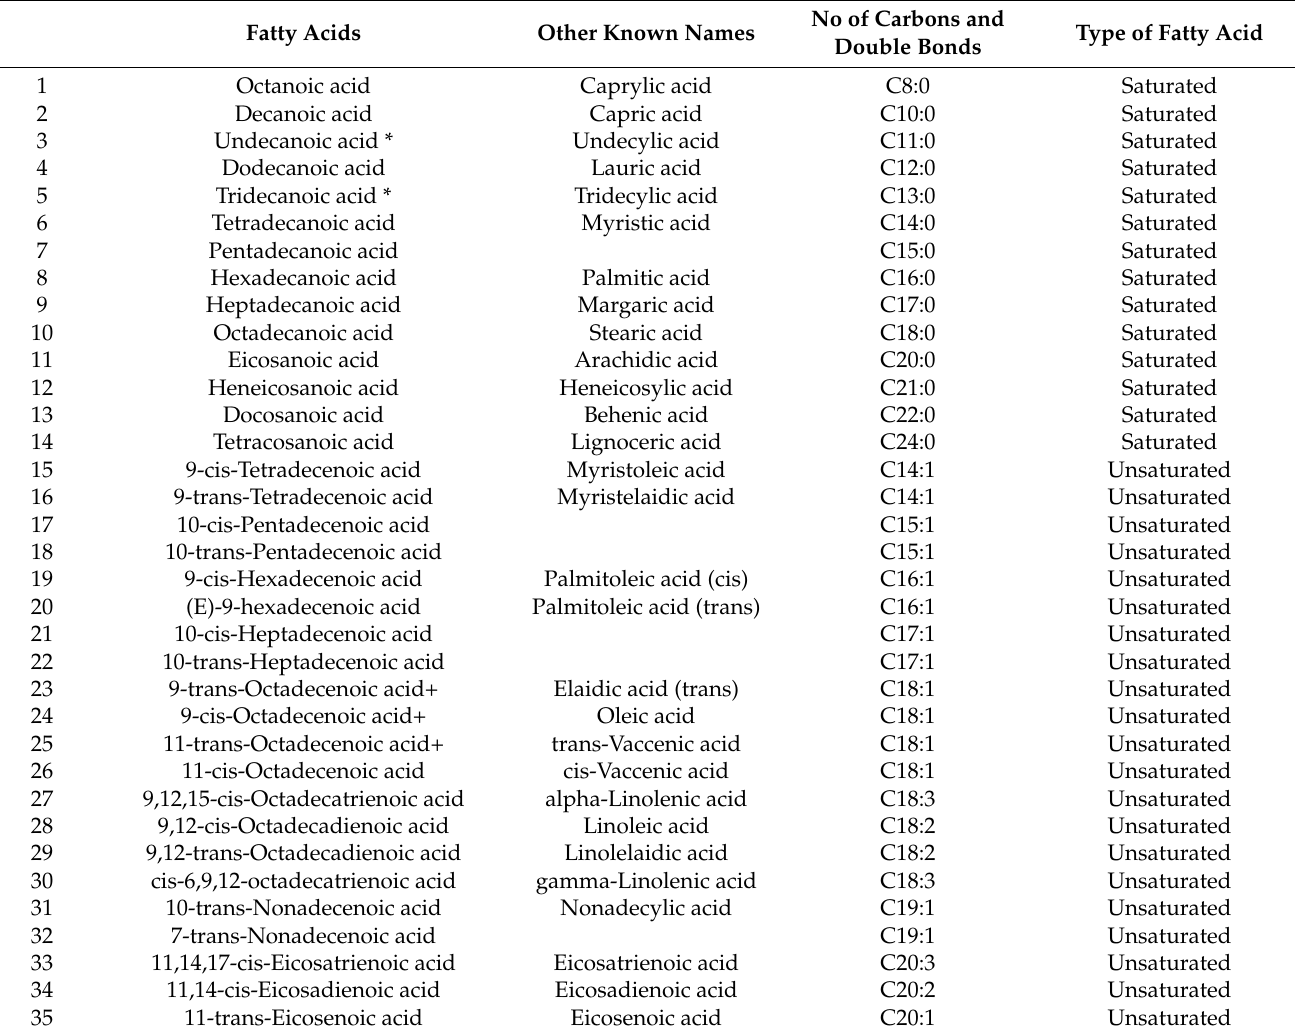
Table 2. List of saturated and unsaturated fatty acids detected and identified in grape juices, extracts and